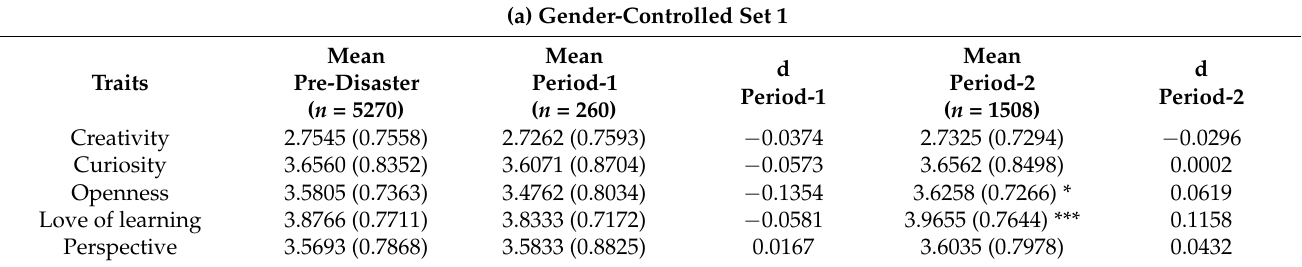
Table A1. Mean scores of the 24 character strengths compared before and during the disaster upon the 5 gender-controlled